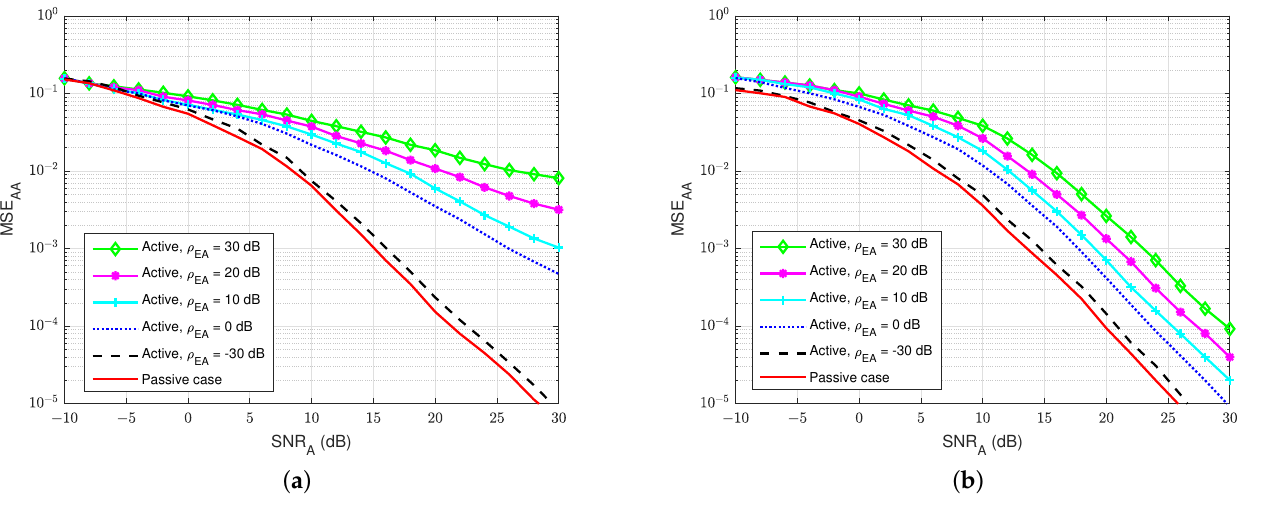
Figure 15. MSE AA versus SNR A , ρ AA = 30 dB in case of active eavesdropper: ( a ) Blind feedback; ( b ) Semi-blind feedback.